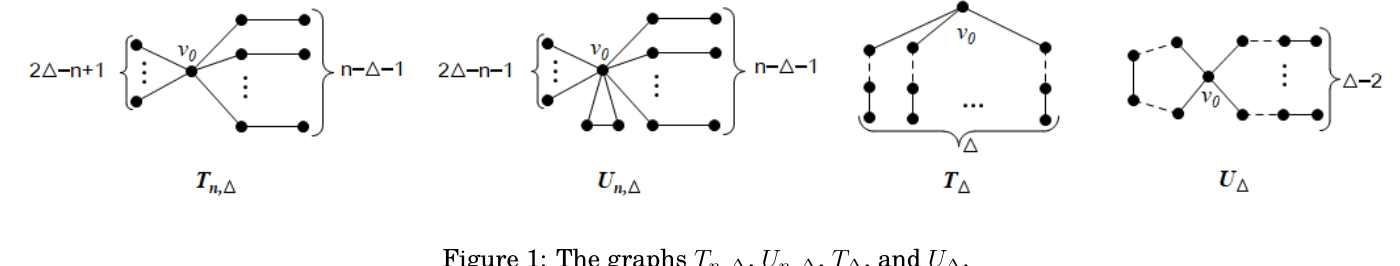
Figure 1: The graphs T n, ∆ , U n, ∆ , T ∆ , and U ∆